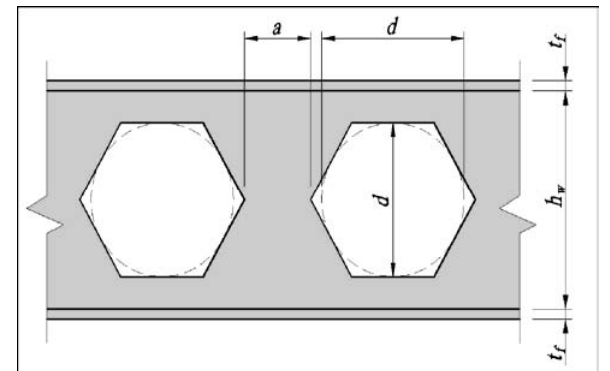
Fig. 2. Geometry of beam’s web with hexagonal form of